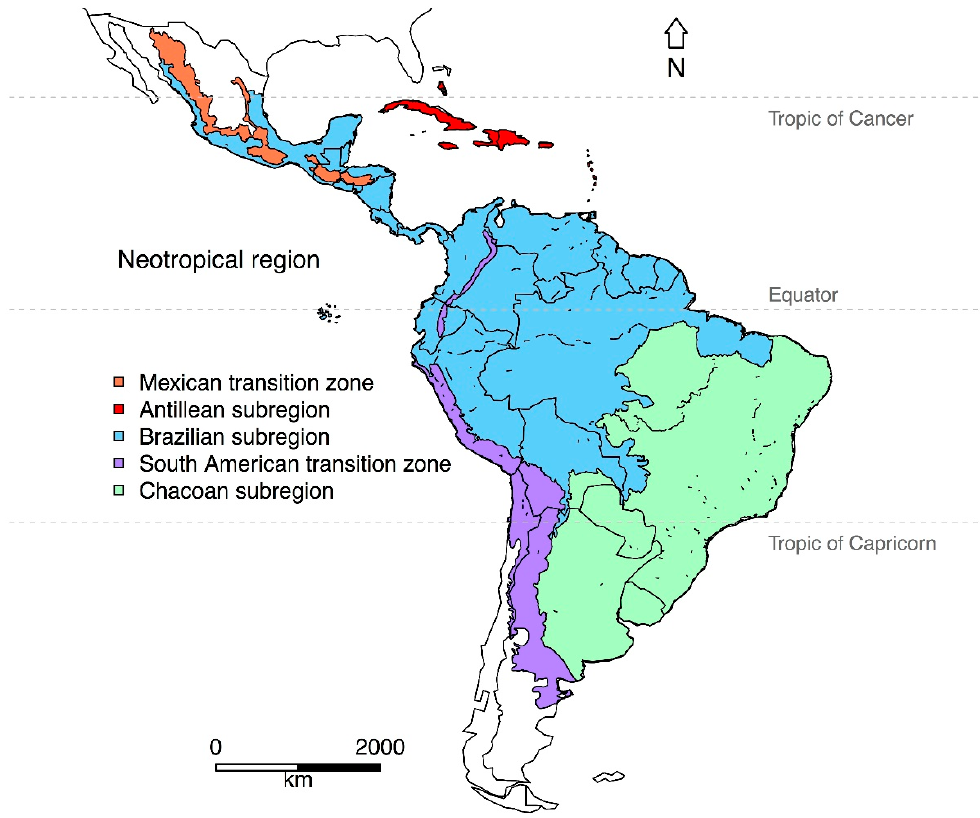
Figure 1. Map of the Neotropical region depicting the transition zones/sub-regions according to the regionalization by Morrone (2014) [6]. Shapefiles downloaded from www.neotropico.com.br/shapefile [32].